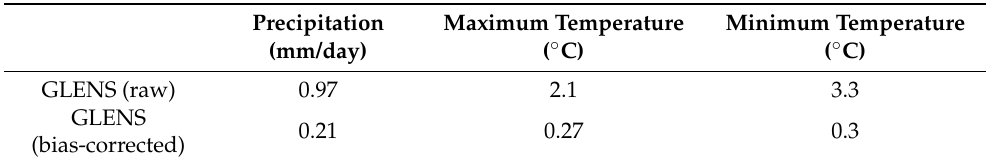
Table 1. The mean absolute error comparing the observation data and raw GLENS simulation and bias-corrected GLENS